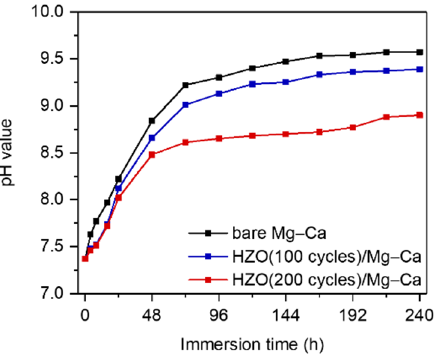
Figure 7. The pH value of SBF solutions as a function of immersion time after immersing bare Mg–Ca alloy, HZO(100 cycles)/Mg–Ca, and HZO(200 cycles)/Mg–Ca specimens.